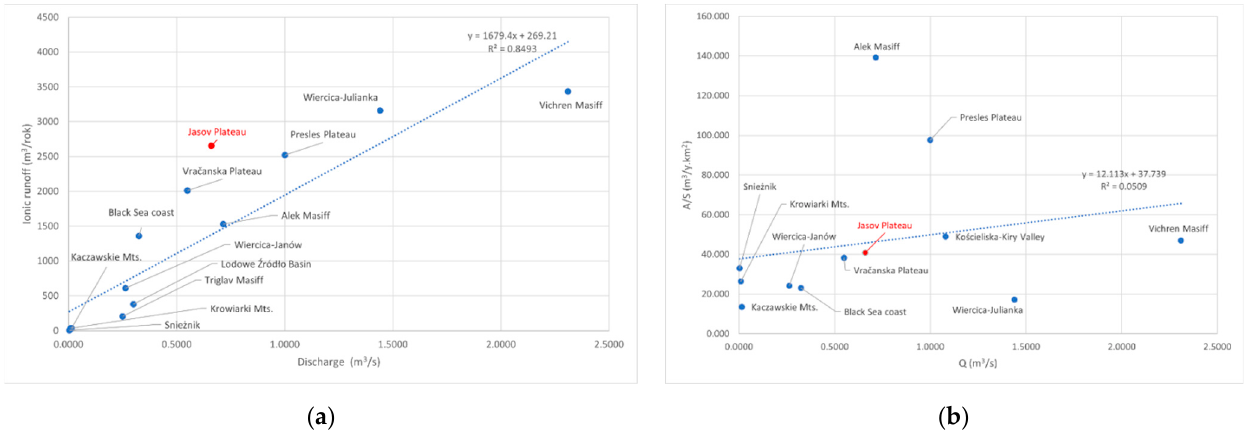
Figure 8. Relationship of ionic runoff and discharge ( a ) and mineralization ( b ). Study areas of [5,23] and Slovak Karst, localities described in Table 2.